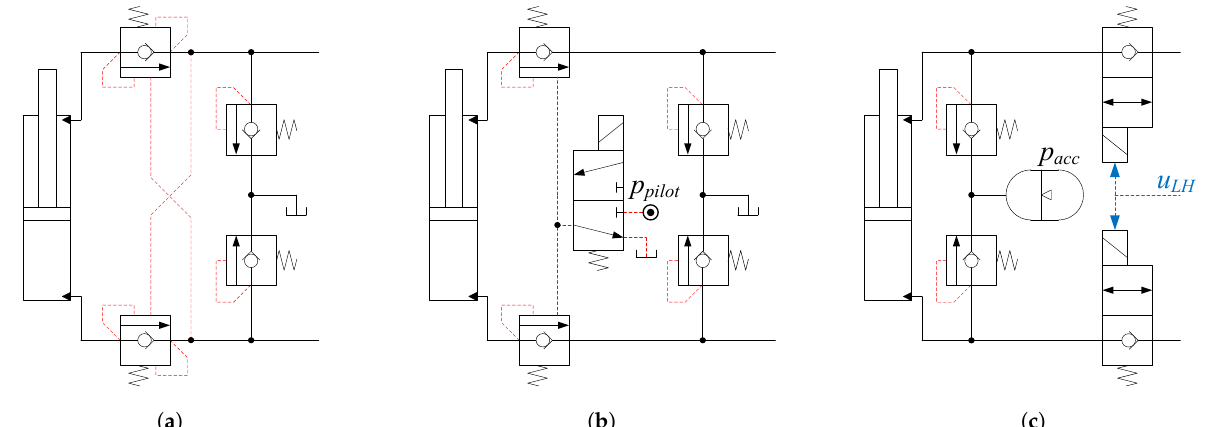
Figure 2. Examples of topologies for load holding and overload handling. ( a ) Traditional counterbalance valves and shock valves for a single rod cylinder; ( b ) Counterbalance valves opened by 3/2-valve and external pilot pressure; ( c ) Load holding design for EHA. Counterbalance valves are used in ( a , b ), while ( c ) uses poppet